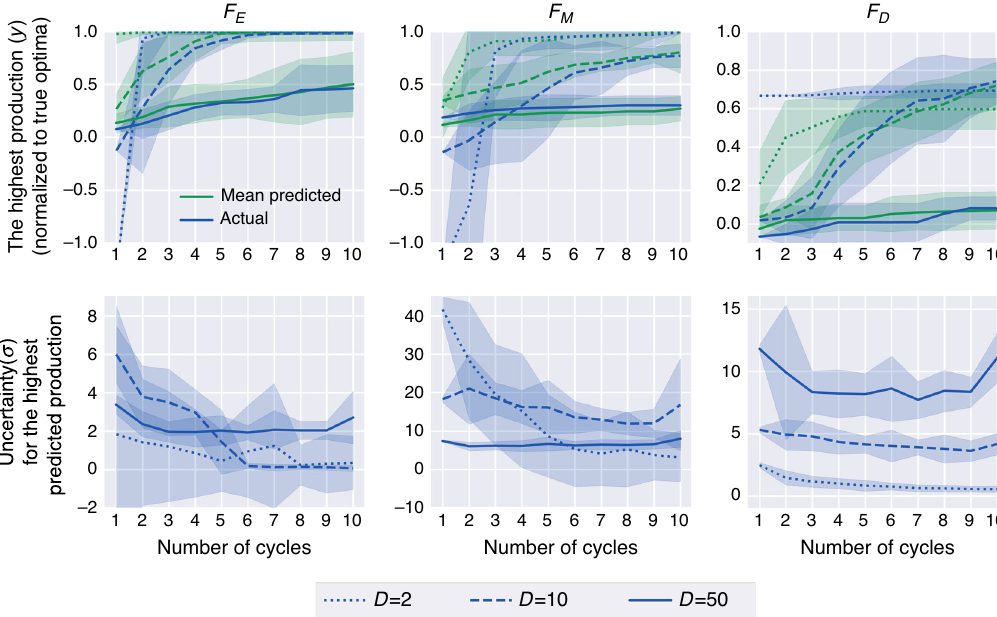
(cid:2) P P d ð x (cid:2) 5 Þ 2 þ exp (cid:2) x 2 i i i i